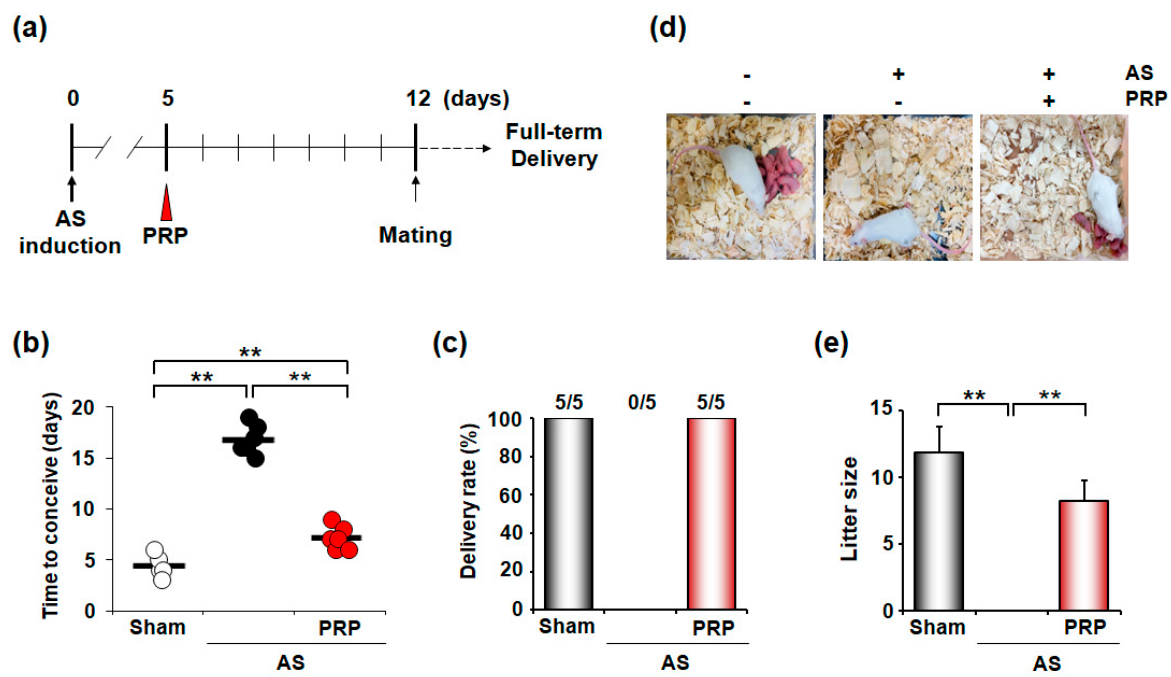
Figure 3. PRP treatment recovers irregular reproductive cycle and poor pregnancy outcome in mice with AS. ( a ) A schematic diagram to show the experimental procedures to examine the therapeutic effects of hPRP on the irregular reproductive cycle and infertility in mice with AS. ( b – e ) Therapeutic effects of hPRP on time to conceive ( b ), delivery rate ( c ), and litter size ( d , e ) in the pregnancy of mice with AS. The horizontal black lines represent median values. Numbers above the bars designate the number of mice that delivered live pup(s)/total number of examined mice. ** p < 0.01.